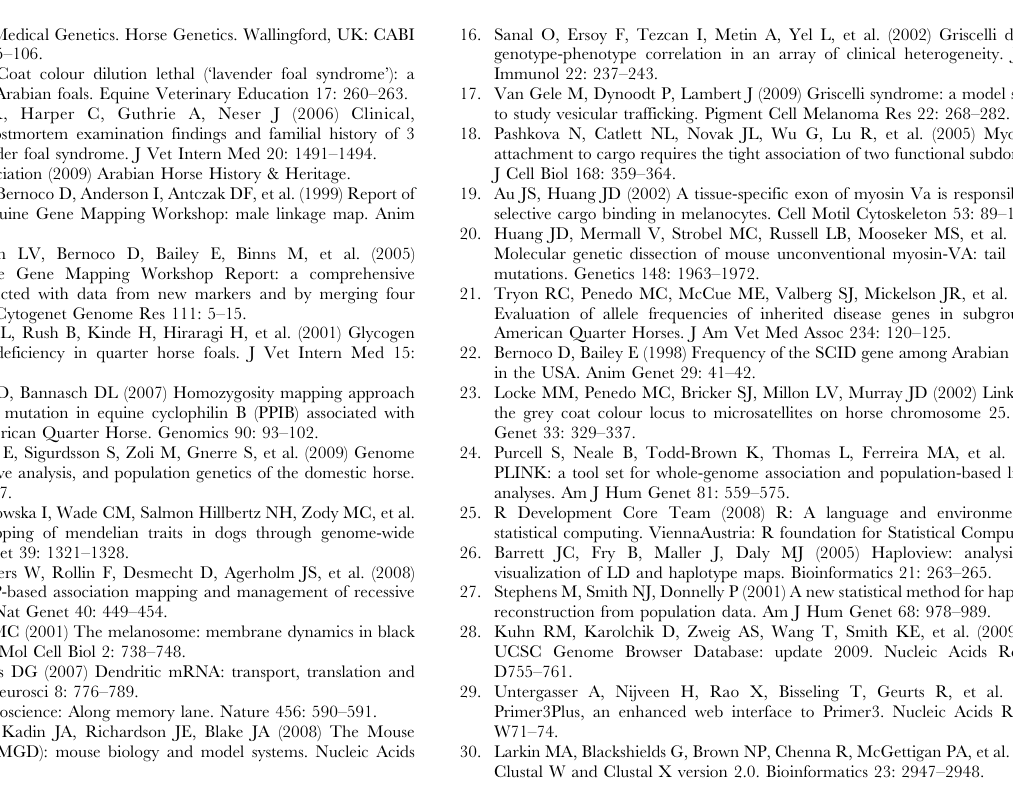
Figure S4 Detection of the Lavender Foal Syndrome associated deletion by PCR-RFLP. Digestion products were visualized by electrophoresis on a 3% gel under UV illumination following staining with SYBR green. A lane of size standard is on the far left followed by (A) a negative control, (B) undigested PCR and the digestion products in lanes, (C) from a normal horse, (D) a carrier, and finally (E) an affected foal. Table S1 Primers sequences used to amplify 39 exons